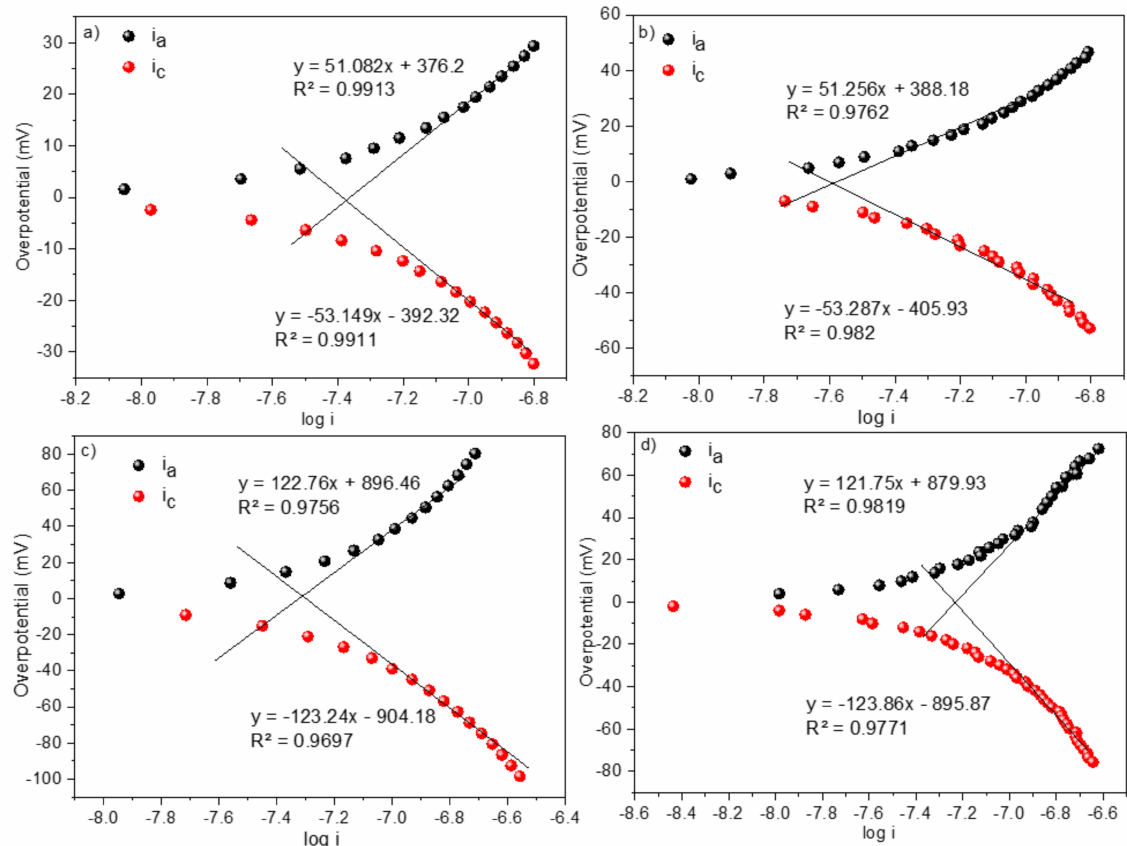
Figure 8. Tafel plots for the redox systems of the polymers: ( a ) 1 ; ( b ) 2 ; ( c ) 3; ( d ) 4